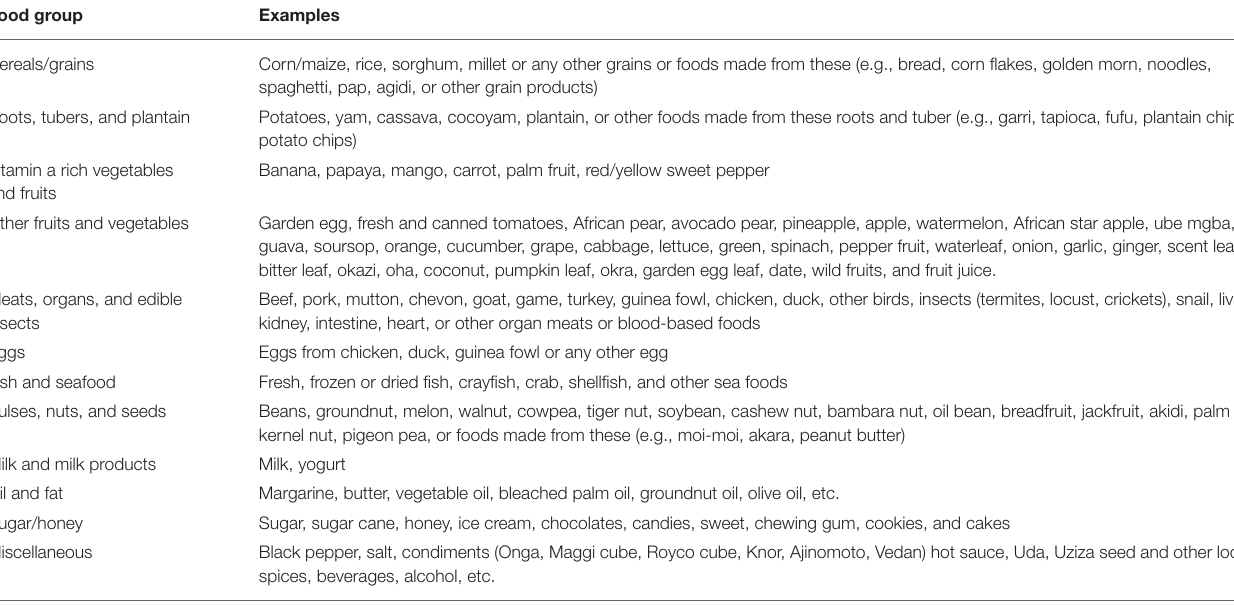
TABLE 1 | Standardized food groups/classifications. Food group Examples